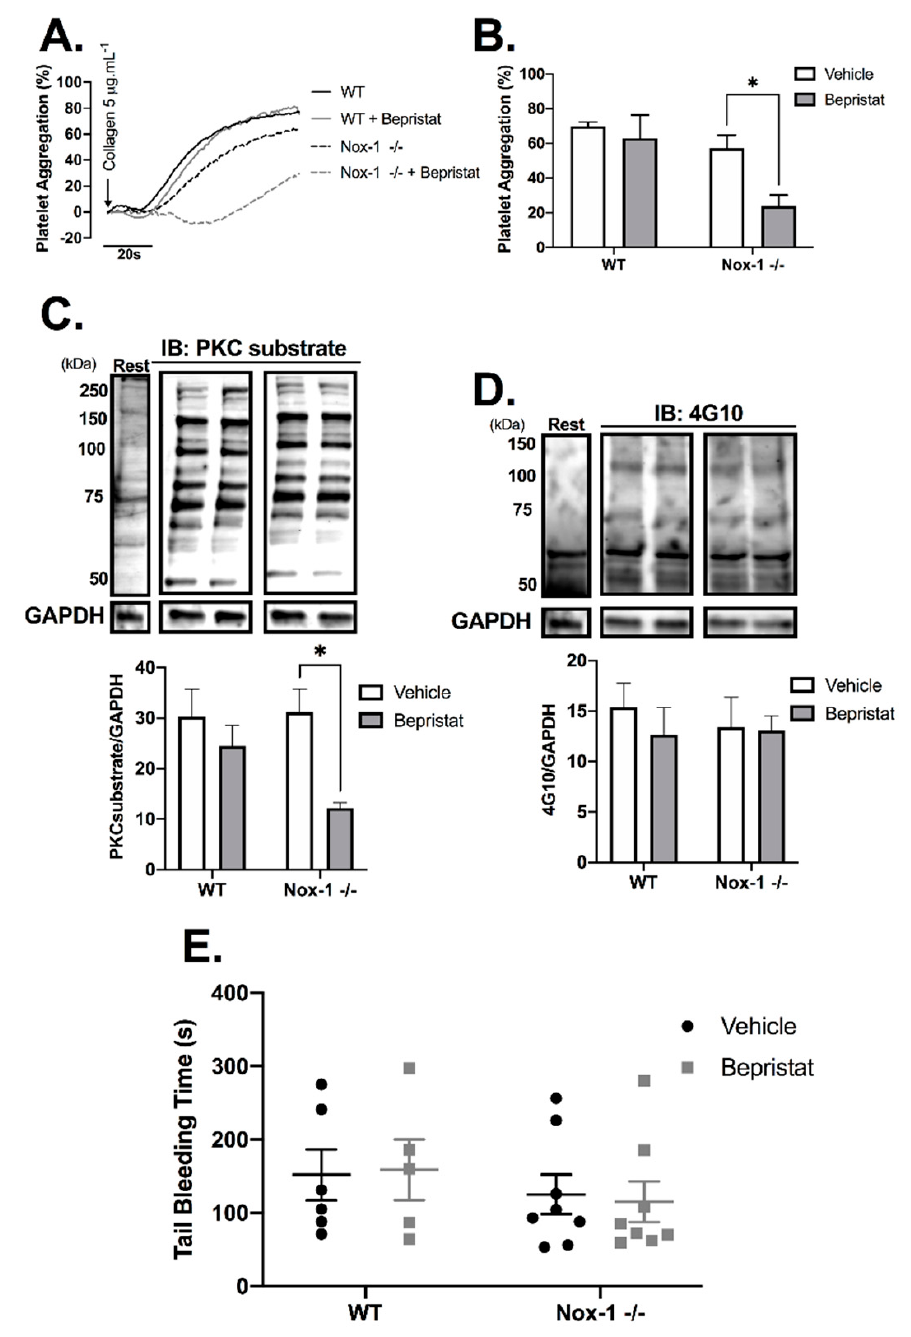
Figure 5. Nox-1 − / − mice treated with bepristat showed additive anti-platelet effects with no repercussion on bleeding time. ( A ) Platelet aggregation curves of mouse wildtype (WT) and Nox-1 − / − platelets pre-treated with 7.5 µ M bepristat or vehicle for 10 min and activated with 5 µ g/mL Collagen. ( B ) Summary statistics of aggregation curves. Immunoblots were performed in platelets pre-treated with 7.5 µ M bepristat or vehicle for 10 min and activated with 5 µ g/mL Collagen for 90 s. ( C ) PKC substrate. ( D ) 4G10 total Tyr phosphorylation. Representative blots are presented on top of bar graphs with summary statistics. Each lane represents the condition in graph below. A basal unstimulated condition is presented (Rest). ( E ) Tail bleeding time in mice injected with 50 µ M bepristat or vehicle control. n = 5–6 for ( A – D ), while n = 5–8 for ( E ). Data on graphs expressed as mean ± SEM analysed by unpaired two-way ANOVA and Sidak’s post-test. * p < 0.05.